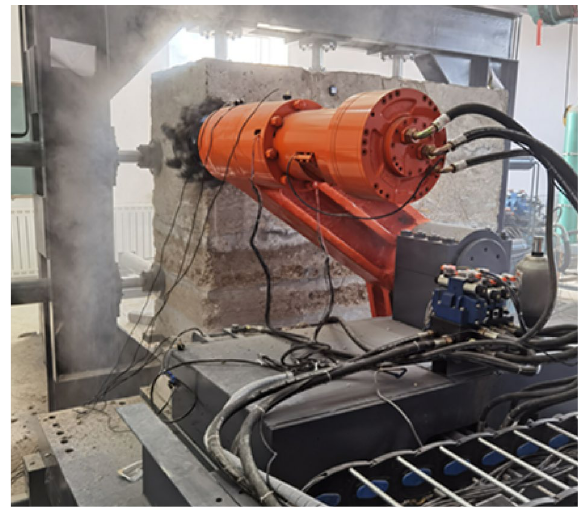
Figure 20. Experimental test process.